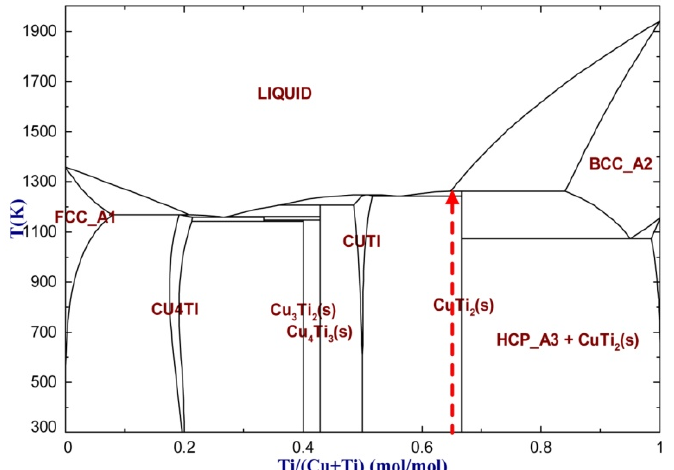
Figure 2. Cu-Ti phase diagram (FactSage 7.3).